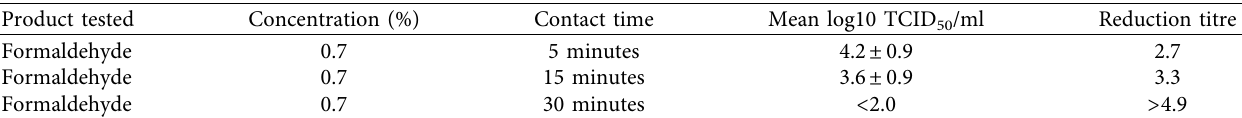
Table 3: Comparative titrations of the SARS-CoV-2 virus after treatment with formaldehyde (0.7%) after 5, 15, and 30 minutes of the contact time.